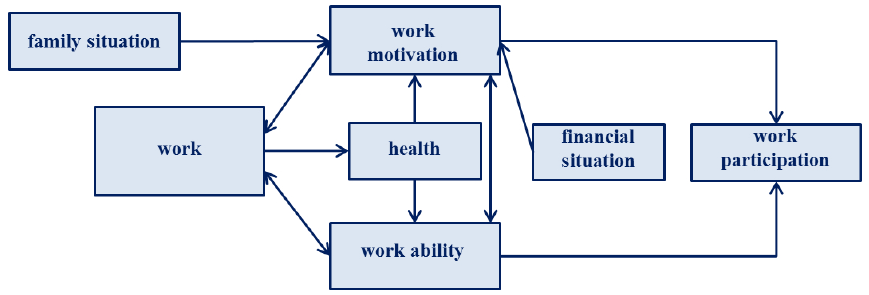
Figure 1. The lidA framework (modified according to Peter & Hasselhorn 2013 [14]).